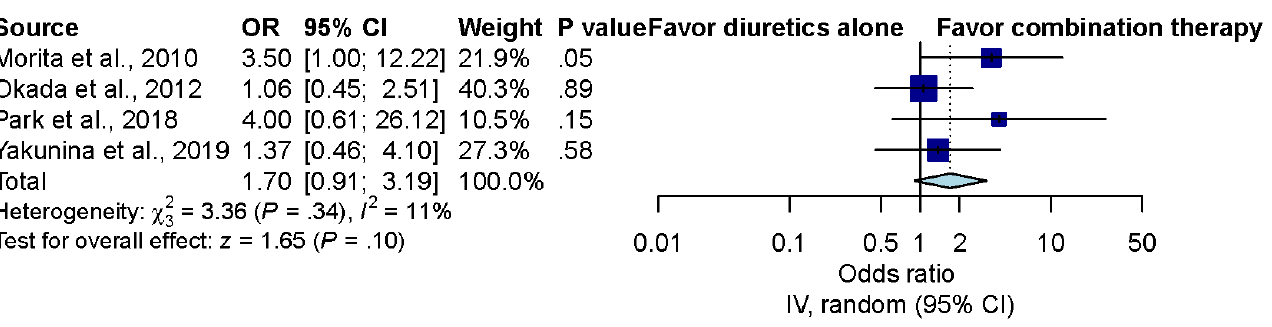
Figure 3. Overall effect of diuretics and combination therapy in ALHL patients [9–11,21].